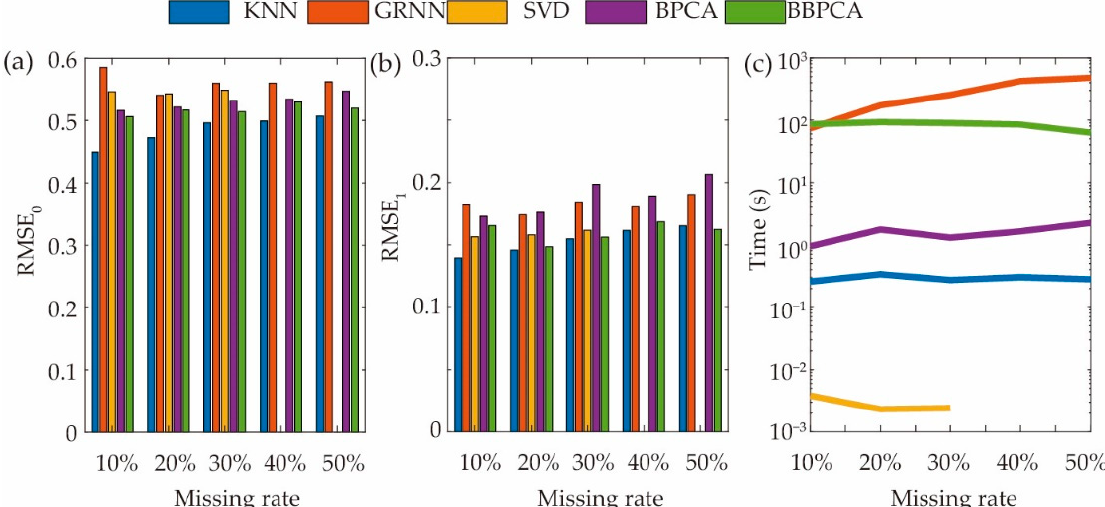
Figure 5. Performance of different single methods to predict the missing values in functional requirements (FRs) ( a ) RMSE of categorical variables; ( b ) root mean squared error (RMSE) of continuous variables; ( c ) computation time.